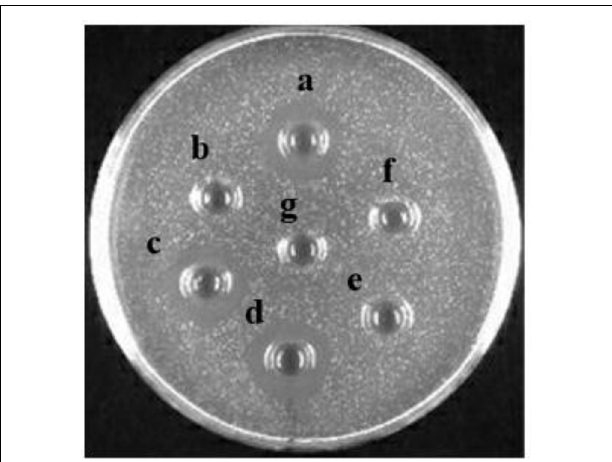
FIGURE 7 | Effect of different proteases on Bacteriocin Lac-B23: (a) cell-free supernatants with no treatment; treated with (b) proteinase E; (c) papain; (d) pepsin; (e) trypsin; (f) proteinase K; and (g) blank